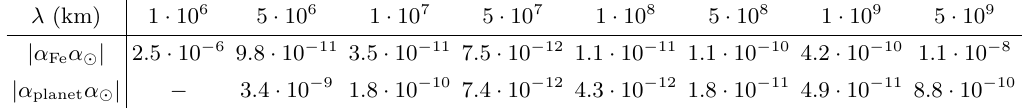
Table 11 . 95% C.L. projected constraints on the combination | α Fe α (cid:12) | [114] and current limits on | α [115] as a function of λ = 1 /m . The constraints due to the planetary orbits are planet α (cid:12) | a dominated by Mars for λ > 2 . 6 · 10 7 km and by Mercury for smaller values of λ